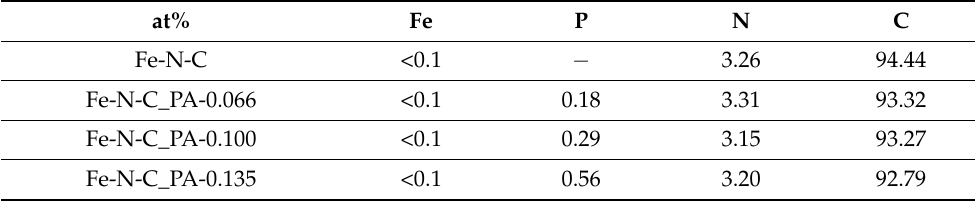
Figure 5. ( a ) N 1 s spectra of Fe-N-C; N 1 s spectra and P 2p spectra of ( b ) Fe-N-C_PA-0.066, ( c ) Fe-N-C_PA-0.100, and ( d ) Fe-N-C_PA-0.135. Table 2. Compositions of Fe-N-C catalysts from XPS survey.